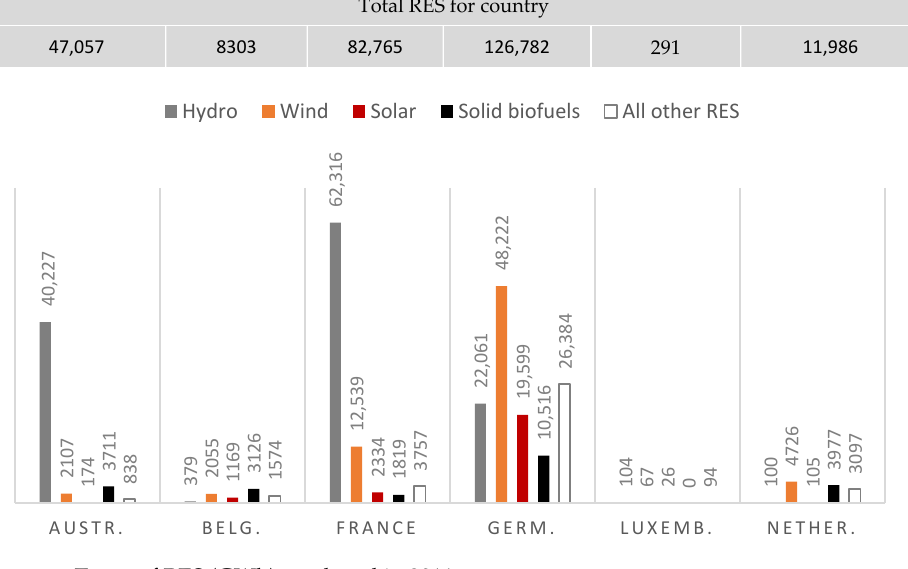
Figure 5. Types of RES (GWh) produced in 2011.